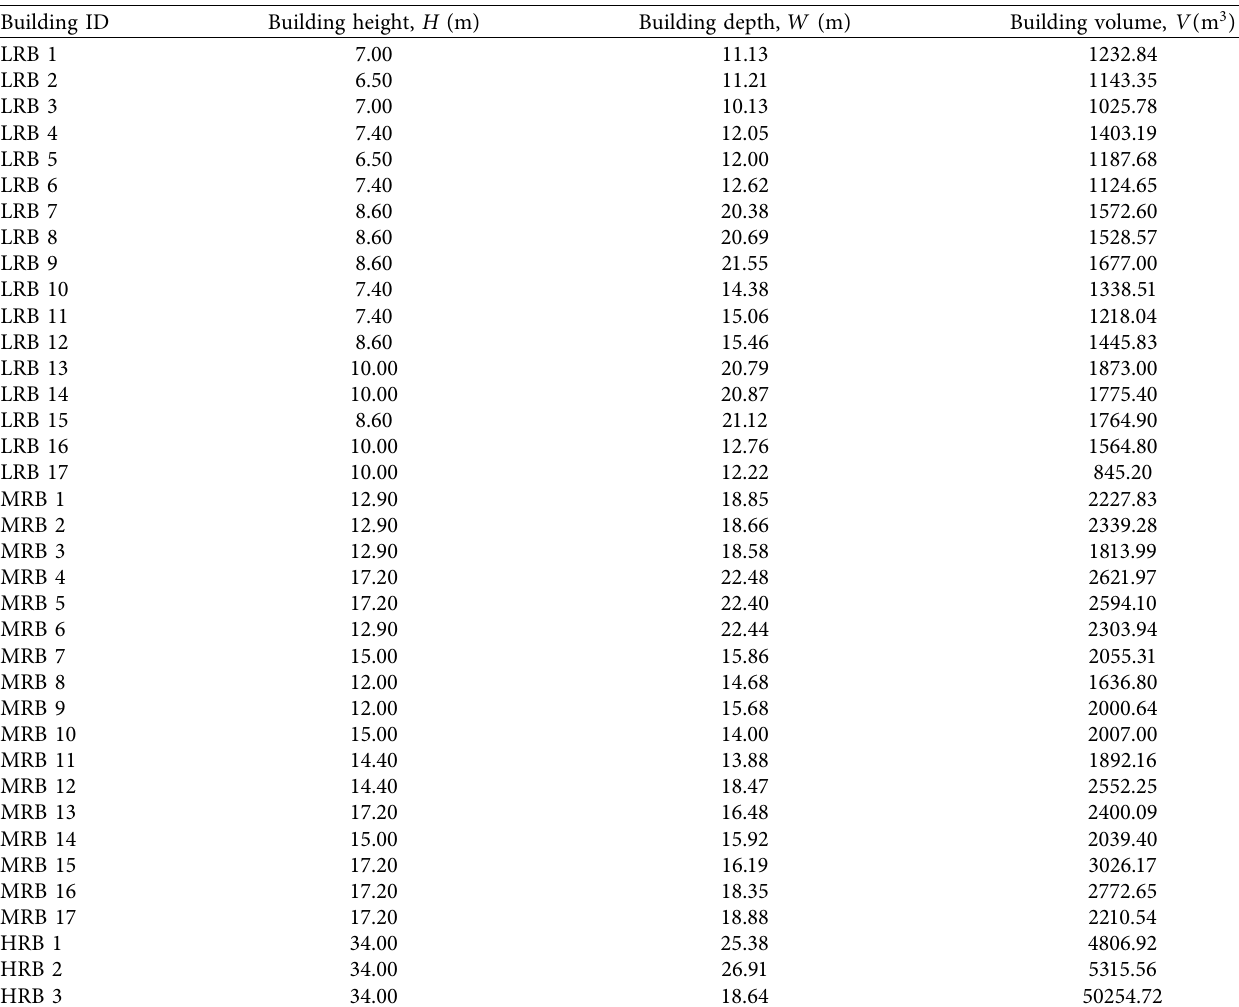
Table 2: Parameter values of main buildings.